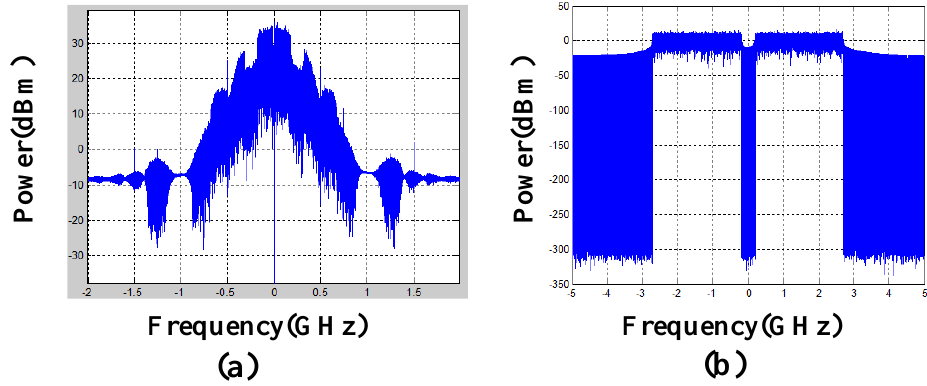
Figure 7. Spectrogram of data ( a ) before and ( b ) after down sampling.